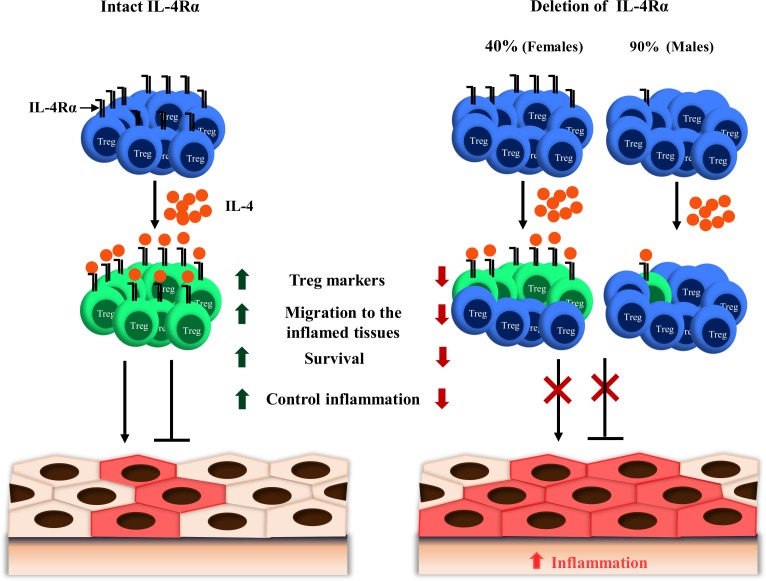
IL-4Rα is required by Treg cells to control inflammation in disease.Schematic diagram showing that either partial or complete deletion of IL-4Rα from Foxp3+ Treg cells leads to aggravated pathology and uncontrolled inflammation, but rather, Foxp3+ Treg cells do require an intact IL-4Rα signaling to control inflammation in diseases. Foxp3, forkhead box P3; IL-4, interleukin-4; IL-4Rα, interleukin-4 receptor alpha; Treg, regulatory T.